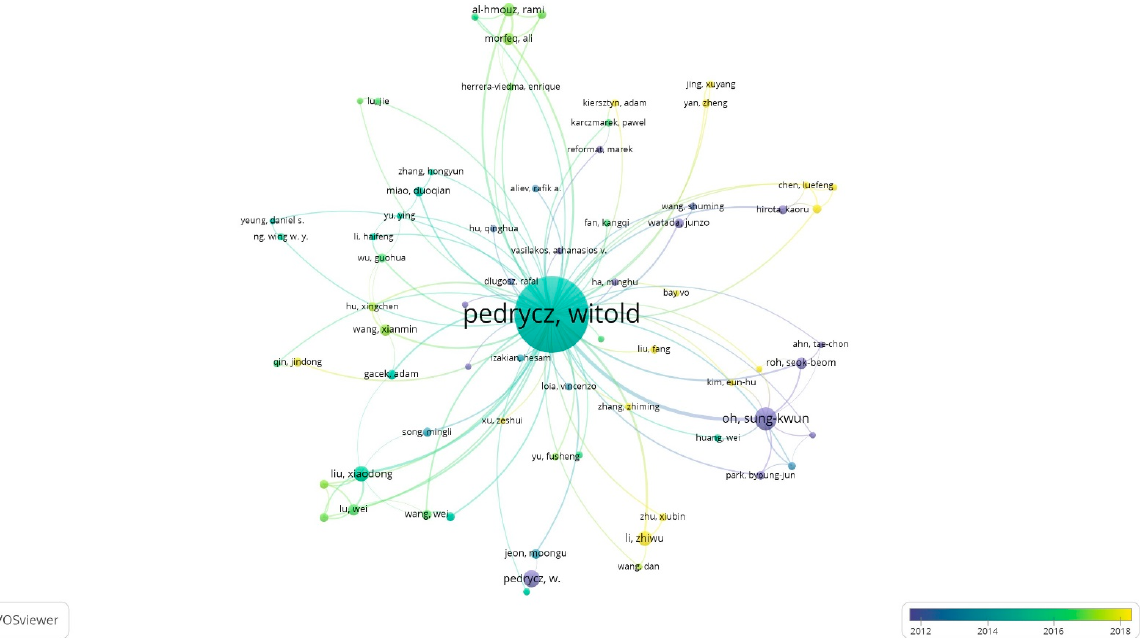
Figure 20. Clusters by authors on VOSviewer.